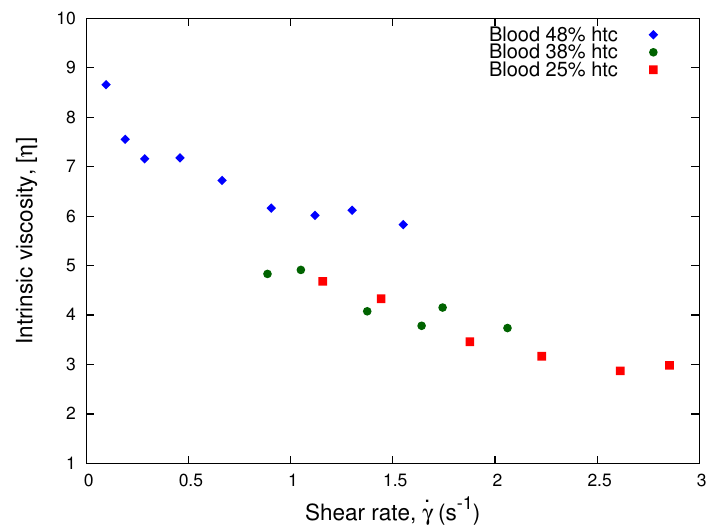
Figure 8. Intrinsic viscosity vs. Shear Rate. The plot shows the normalization process performed using the linear approximation of the Krieger and Dougherty model, Equation (17), for different donor